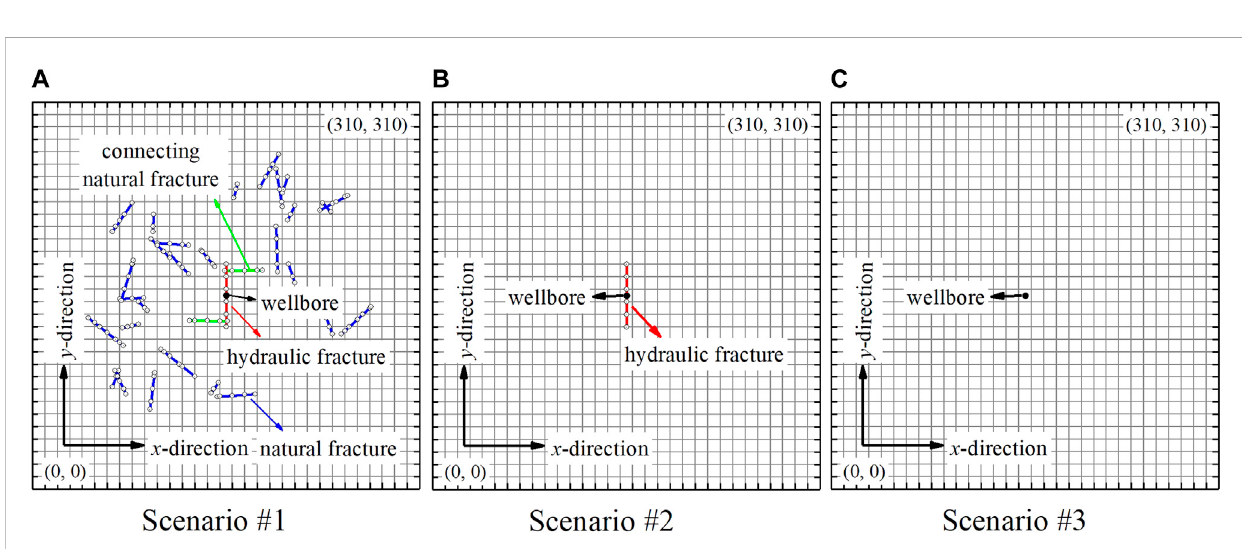
Schematics of the different scenarios to investigate the effect of fracture networks: (A) scenario with natural fractures and hydraulic fracture; (B) scenario with hydraulic fracture; (C) scenario without natural fractures and